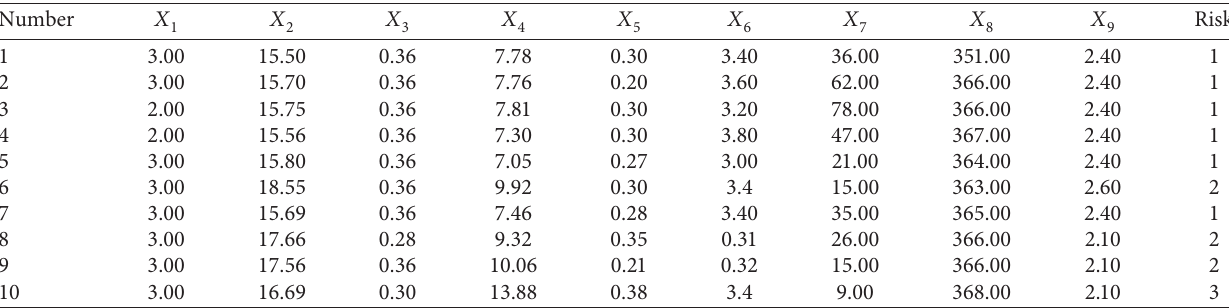
Figure 1: The location of the test sample collection and the geological parameters of the coal seam. (a) Location of test sample collection. (b) #3 coal seam geological parameters. Table 1: Part sample data of #3 coal seam 31004 driving